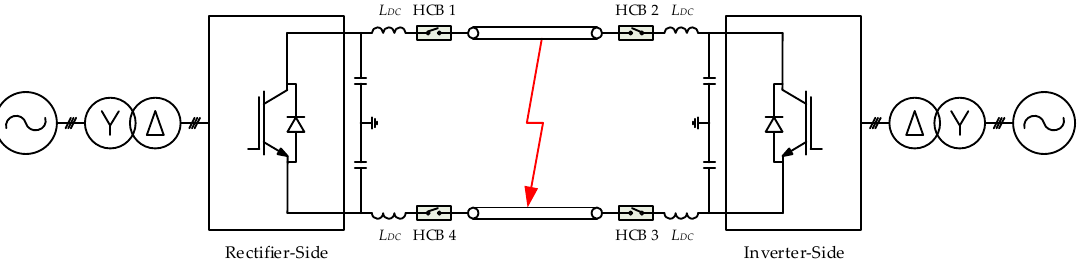
Figure 7. Configuration of the voltage source converter-based high voltage direct current (VSC- HVDC) model.